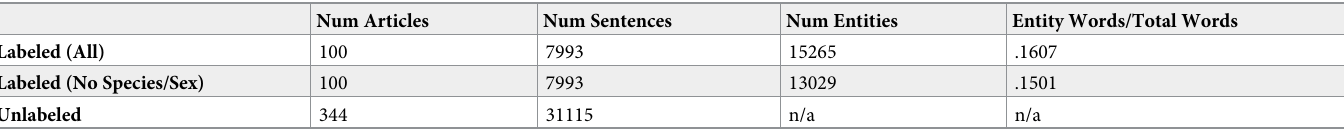
Table 7. Detailed information about the TAC SRIE dataset.